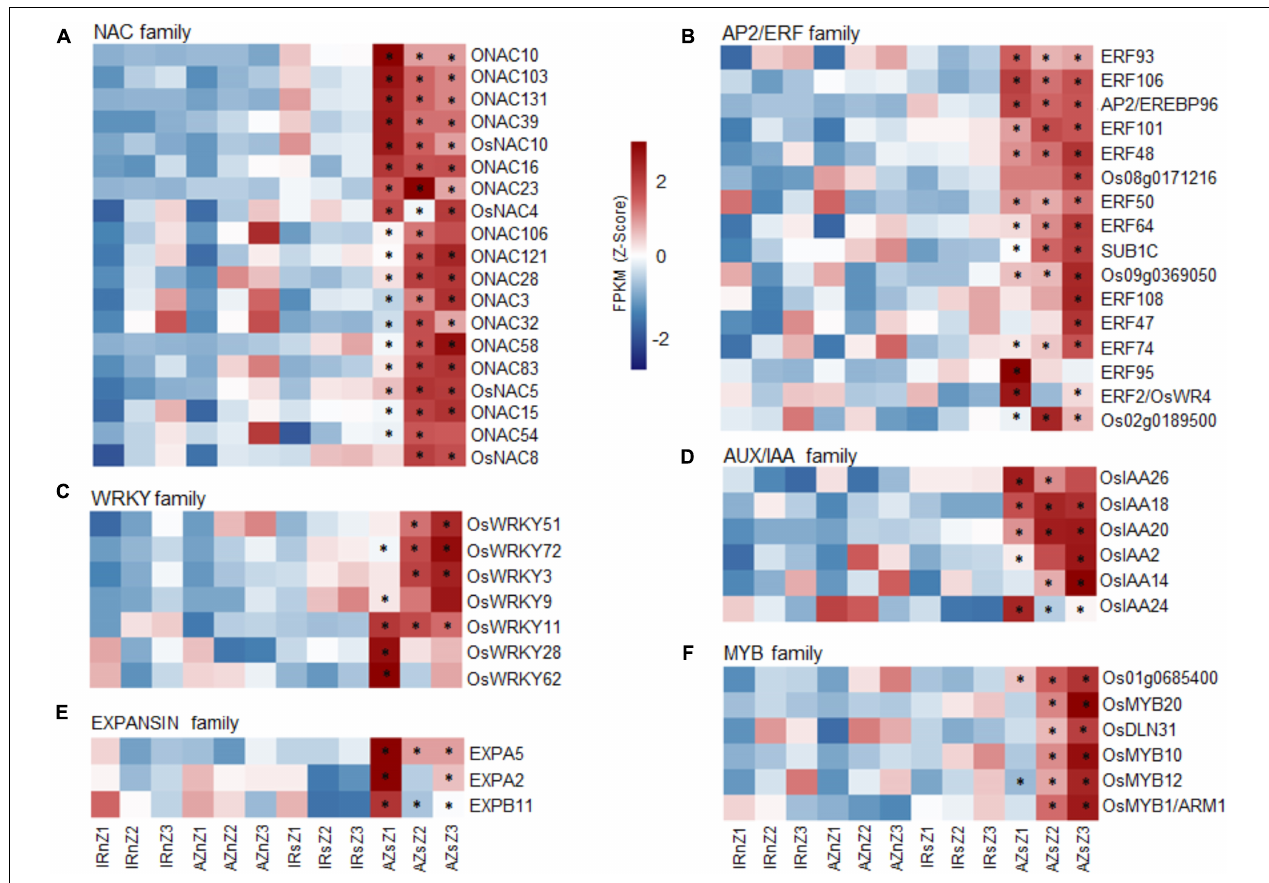
FIGURE 7 | Gene family studies across contrasting genotypes in response to water stress. Heatmaps showing the expression pattern of members of (A) NAC , (B) AP2/ERF , (C) WRKY , (D) AUX/IAA , (E) EXPANSIN , (F) MYB gene families, upregulated in Azucena roots in response to water stress compared to IR64 genotype. The color bar depicts the gradient of FPKM mean ( Z -score) for each sample. The asterisks indicate genes with significant interactions between genotypes and conditions ( p ≤ 0.05) by two-way ANOVA test. IRnZ1, root zone 1 of IR64 under normal condition; IRnZ2, root zone 2 of IR64 under normal condition; IRnZ3, root zone 3 of IR64 under normal condition; IRsZ1, root zone 1 of IR64 under stress condition; IRsZ2, root zone 2 of IR64 under stress condition; IRsZ3, root zone 3 of IR64 under stress condition; AZnZ1, root zone 1 of Azucena under normal condition; AZnZ2, root zone 2 of Azucena under normal condition; AZnZ3, root zone 3 of Azucena under normal condition; AZsZ1, root zone 1 of Azucena under stress condition; AZsZ2, root zone 2 of Azucena under stress condition; AZsZ3, root zone 3 of Azucena under stress